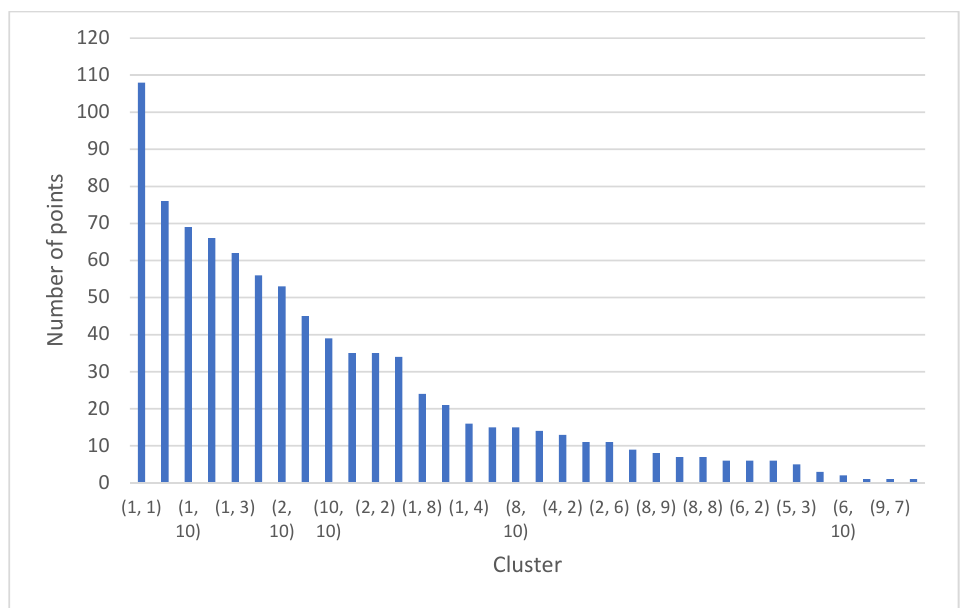
Table 31. Representation of companies in cluster (1, 1) in the years